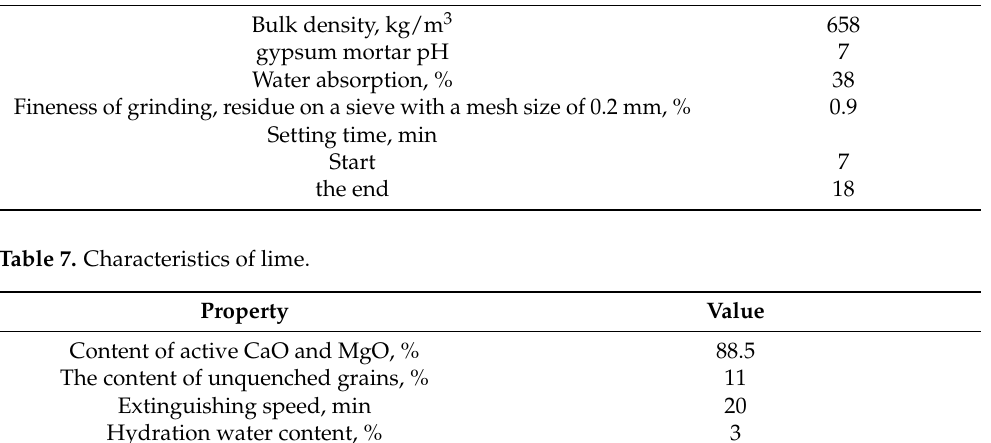
Fineness of grinding, residue on a sieve with a mesh size of 0.2 mm, %